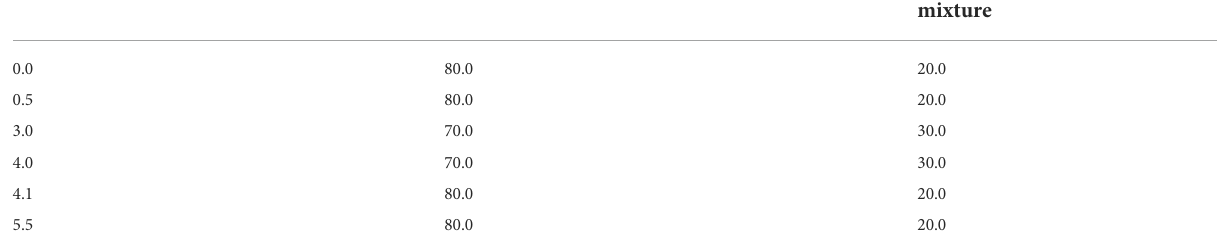
TABLE 1 The gradient